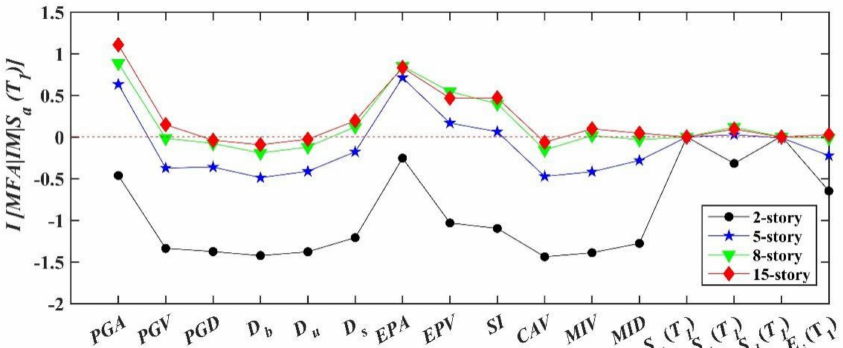
Figure 11. I ( IM 2 | IM 1 ) between IMs and MFA , obtained via the cloud analysis of four typical structures subjected to pulse-like ground motions.